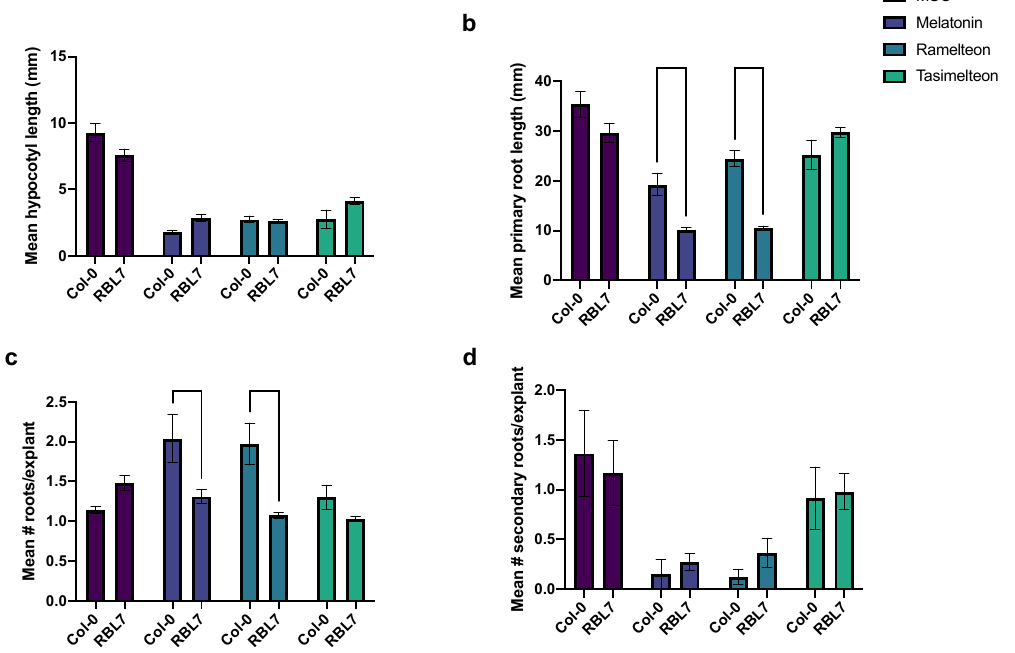
Figure 5. Growth effects ( a ) Mean hypocotyl length, ( b ) Mean primary root length, ( c ) Mean number of roots per explants and ( d ) Mean number of secondary roots per explant, of treatment with melatonin (100 µM) and melatonin agonists ramelteon (10 µM) and tasimelteon (10 µM) in Arabidopsis thaliana Col-0 and rhomboid-like protein 7 (RBL7) mutant seedlings. Data are displayed as mean, error bars extend to the range of standard error, bars between treatments indicate significant differences by analysis of variance with Sidak multiple comparison model between Col-0 and rbl7 mutant (alpha = 0.05) between WT and rbl7 mutant under a particular treatment, where not indicated, no significant difference was